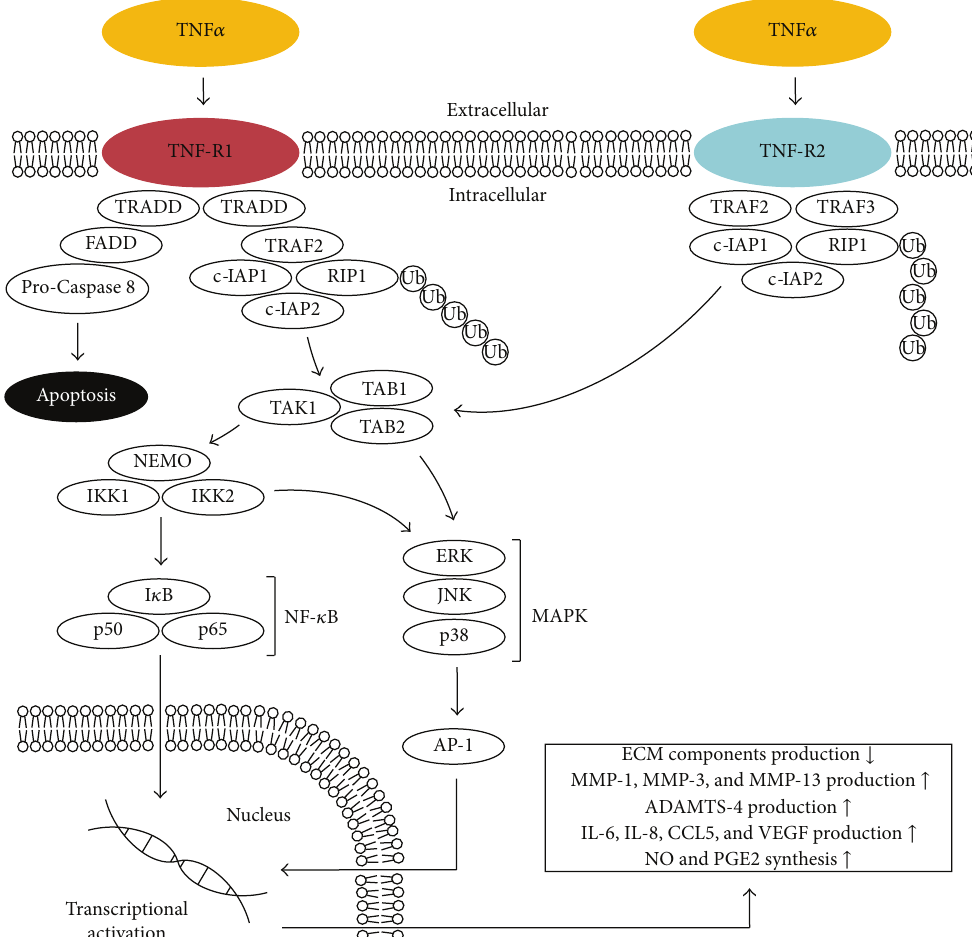
Figure 3: TNF 𝛼 associated intracellular signaling pathways and downstream cellular targets and effects. TNF-R1: tumor necrosis factor receptor superfamily member 1; TNF-R2: tumor necrosis factor receptor superfamily member 2; TRADD: tumor necrosis factor receptor type 1 associated death domain protein; FADD: Fas-associated protein with death domain; TRAF2: TNF receptor-associated factor 6; c-IAP1: also known as Baculoviral IAP repeat-containing protein 2 (BIRC2); c-IAP2: also known as Baculoviral IAP repeat-containing protein 3 (BIRC3); RIP1: receptor-interacting protein kinase 1; Ub: ubiquitin; TRAF3: TNF receptor-associated factor 3; TAK1: also known as